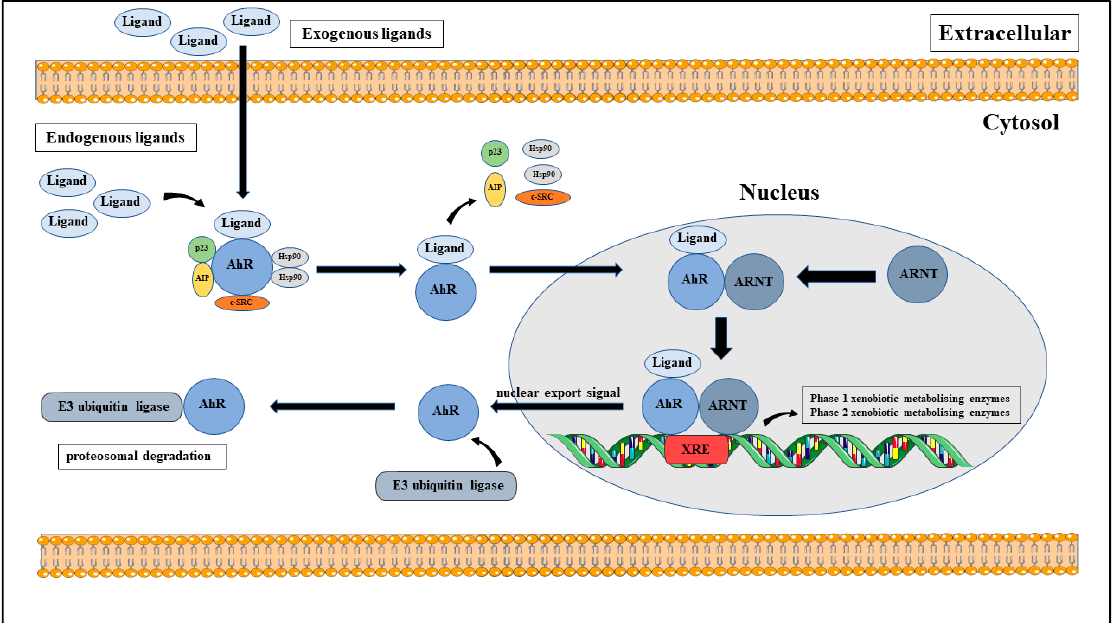
Figure 3. Canonical aryl hydrocarbon receptor (AhR) activation pathway.